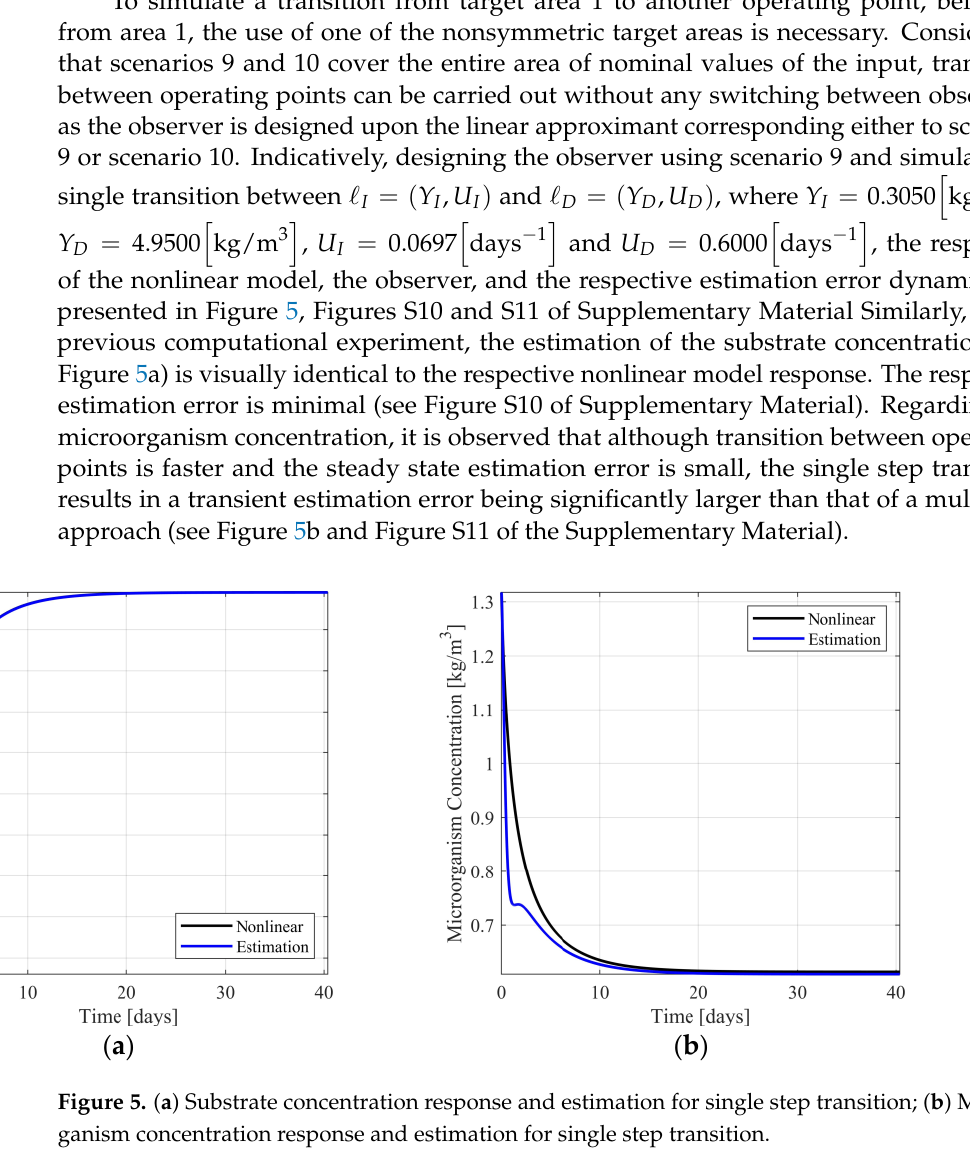
Figure 5. ( a ) Substrate concentration response and estimation for single step transition; ( b ) Microorganism concentration response and estimation for single step transition.